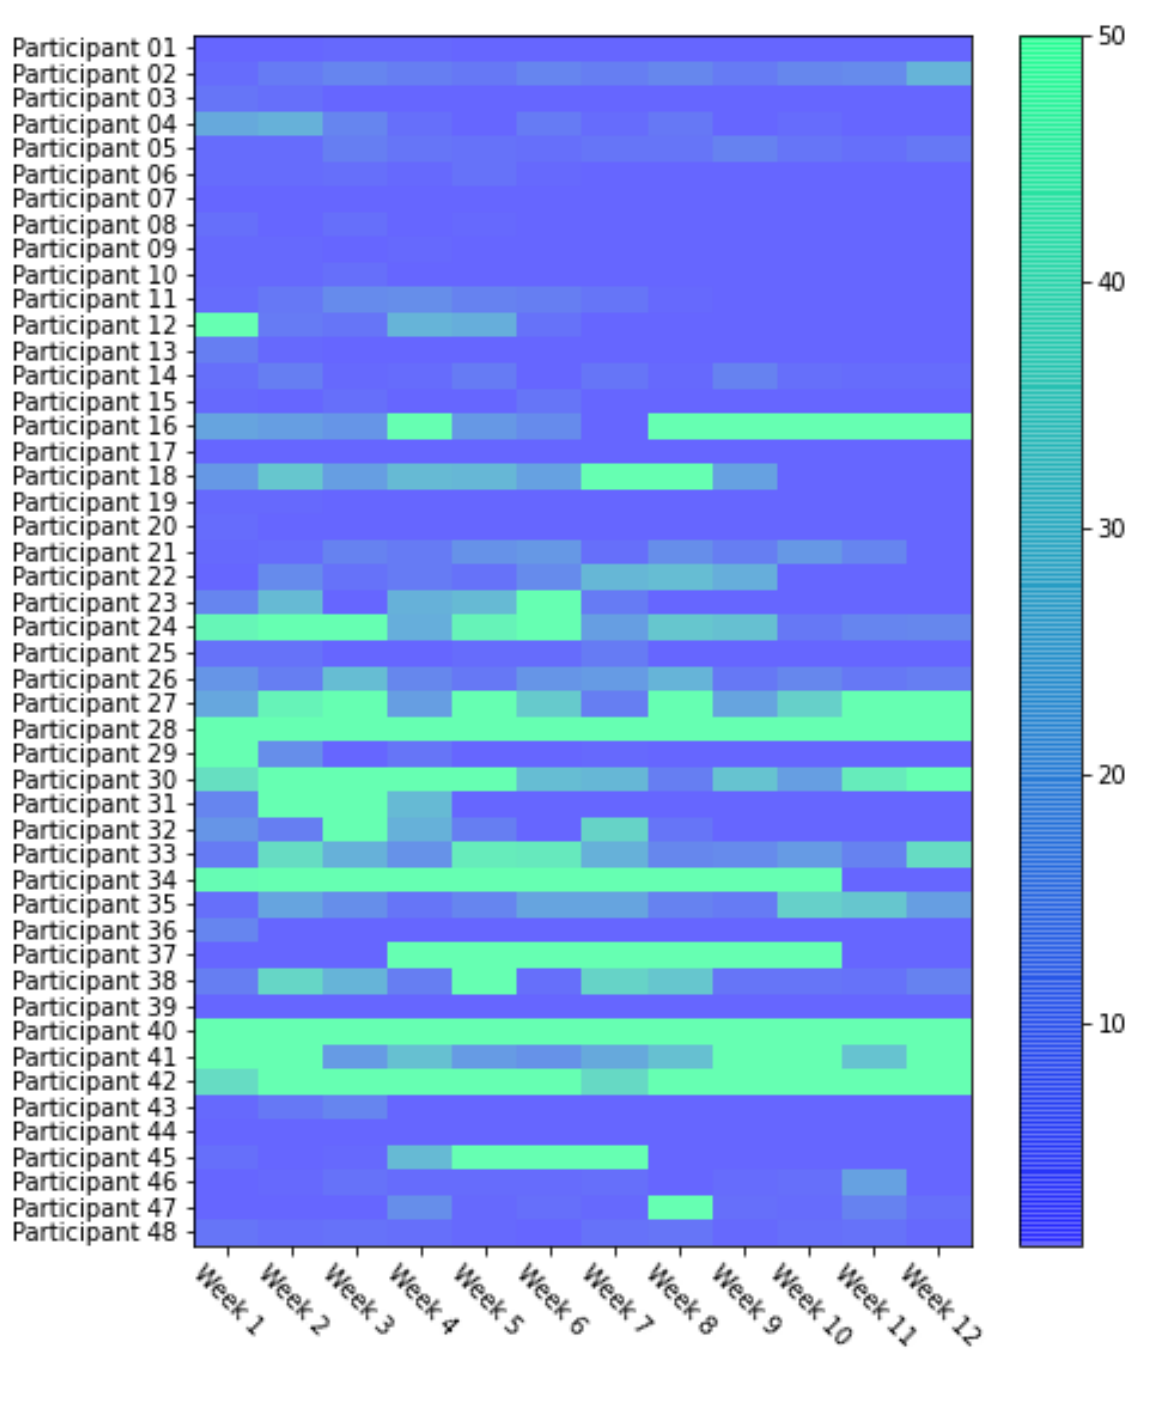
Figure 3. A heatmap of user activity across all sources of data during the